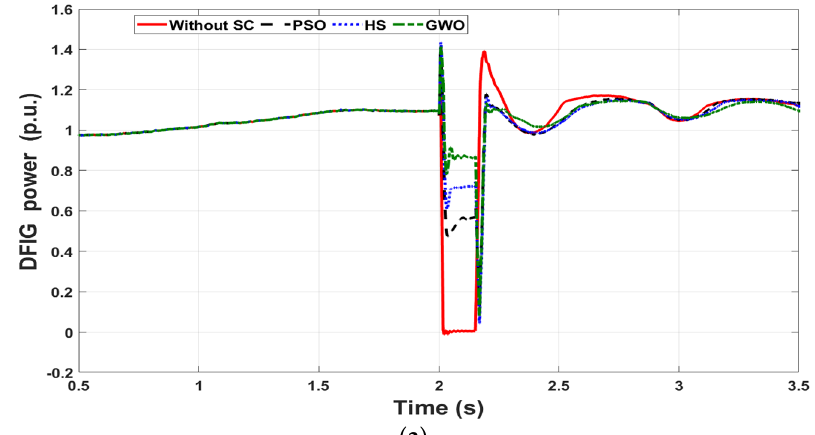
Figure 11. DC-link voltage during the three-phase fault case study.